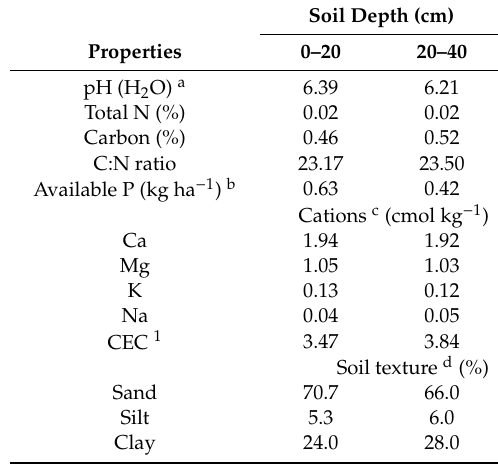
Table 1. Chemical properties of soil on the study site at Hatfield Experimental Farm, University of